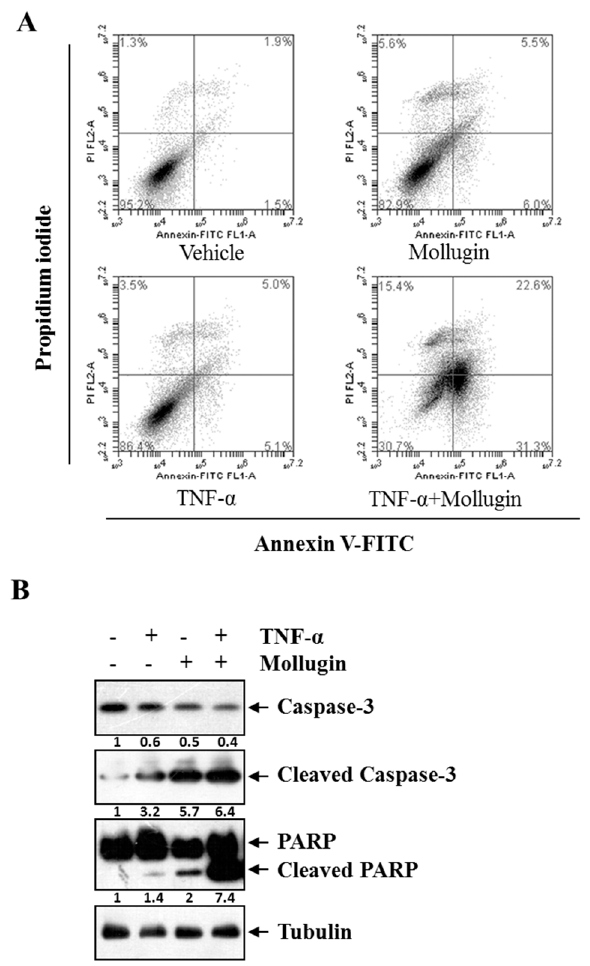
Figure 4. Mollugin potentiates TNF- α -induced apoptosis. ( A ) HeLa cells were pre-incubated in the presence of 80 μ M mollugin for 12 h prior to treatment with 10 ng/mL TNF- α for 24 h. Then, the cells were collected and labelled with Annexin V-FITC and propidium iodide for staining. The stained cells were analyzed using a flow cytometer. The lower right quadrant represented the early apoptotic cell (Annexin-V+ and PI − ) and the upper right quadrant represented the late apoptotic cells (Annexin-V+ and PI+); ( B ) HeLa cells were pre-incubated in the presence of 80 μ M mollugin for 12 h prior to treatment with 10 ng/mL TNF- α for 24 h. Western blot assay was performed for the total and cleaved capase-3, PARP. Tubulin was used as an internal control.